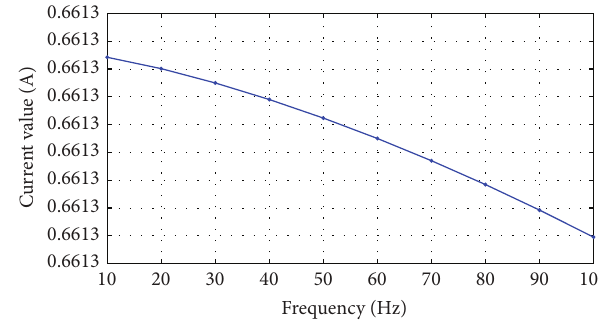
Figure 12: Curve of the maximum current value with the frequency.